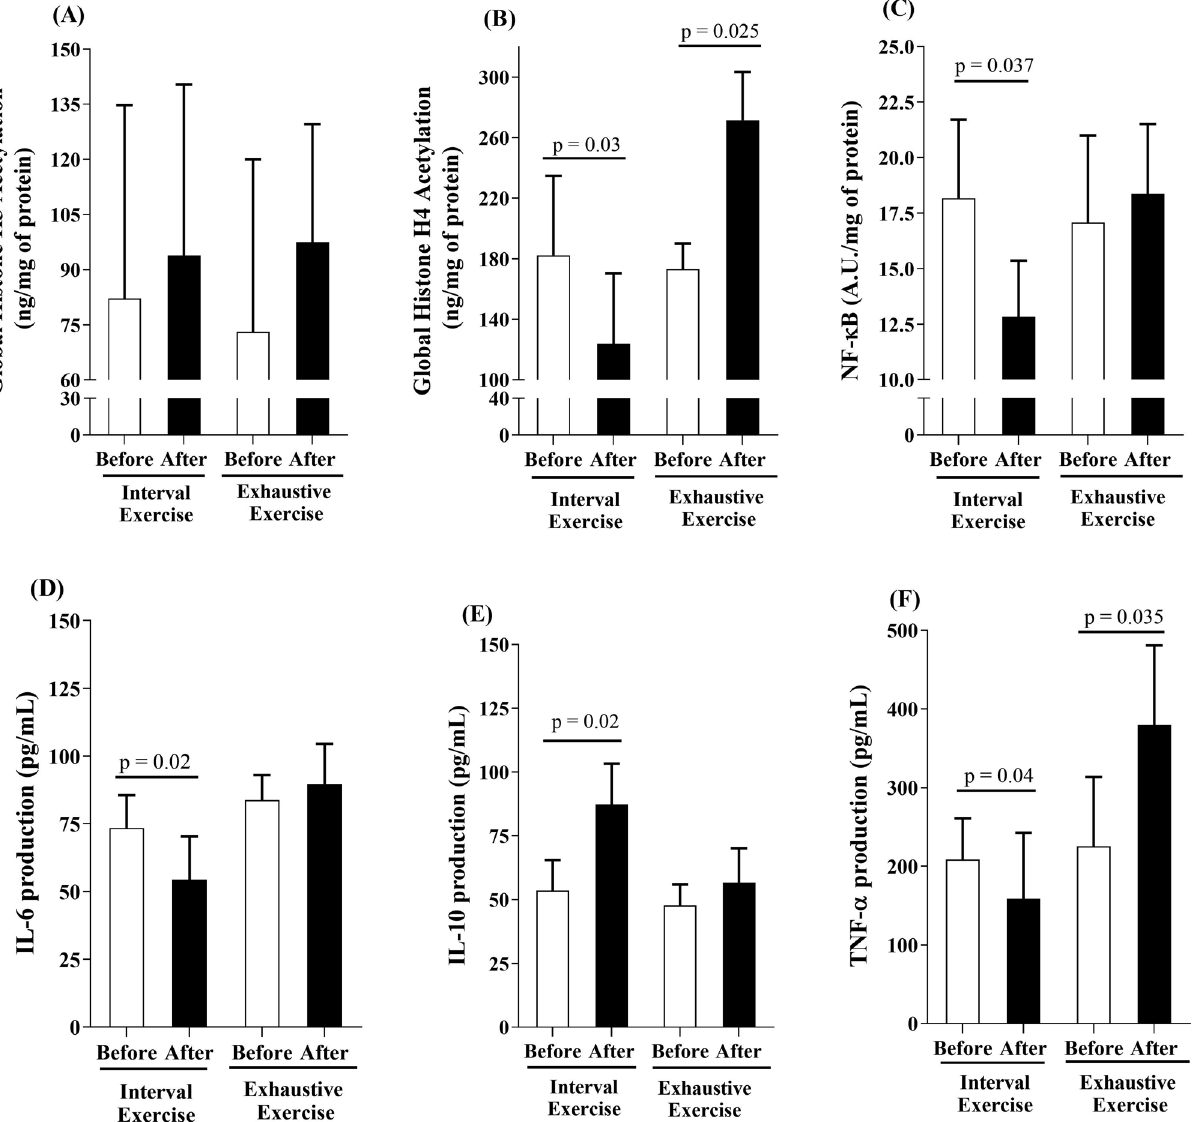
Figure 3. Epigenetic markers, NF-κB content and cytokine production in peripheral blood mononuclear cells incubated in vitro with autologous serum from before (white bars) and after (black bars) two types of exercise. Intracellular content of global H3ac ( 2A ), H4ac ( 2B ), Nuclear factor kappa B ( 2C ) in PBMC, and the production of IL-6 ( 2D ), IL-10 ( 2E ) and TNF-α ( 2F ) by PBMC incubated with serum collected before and immediately